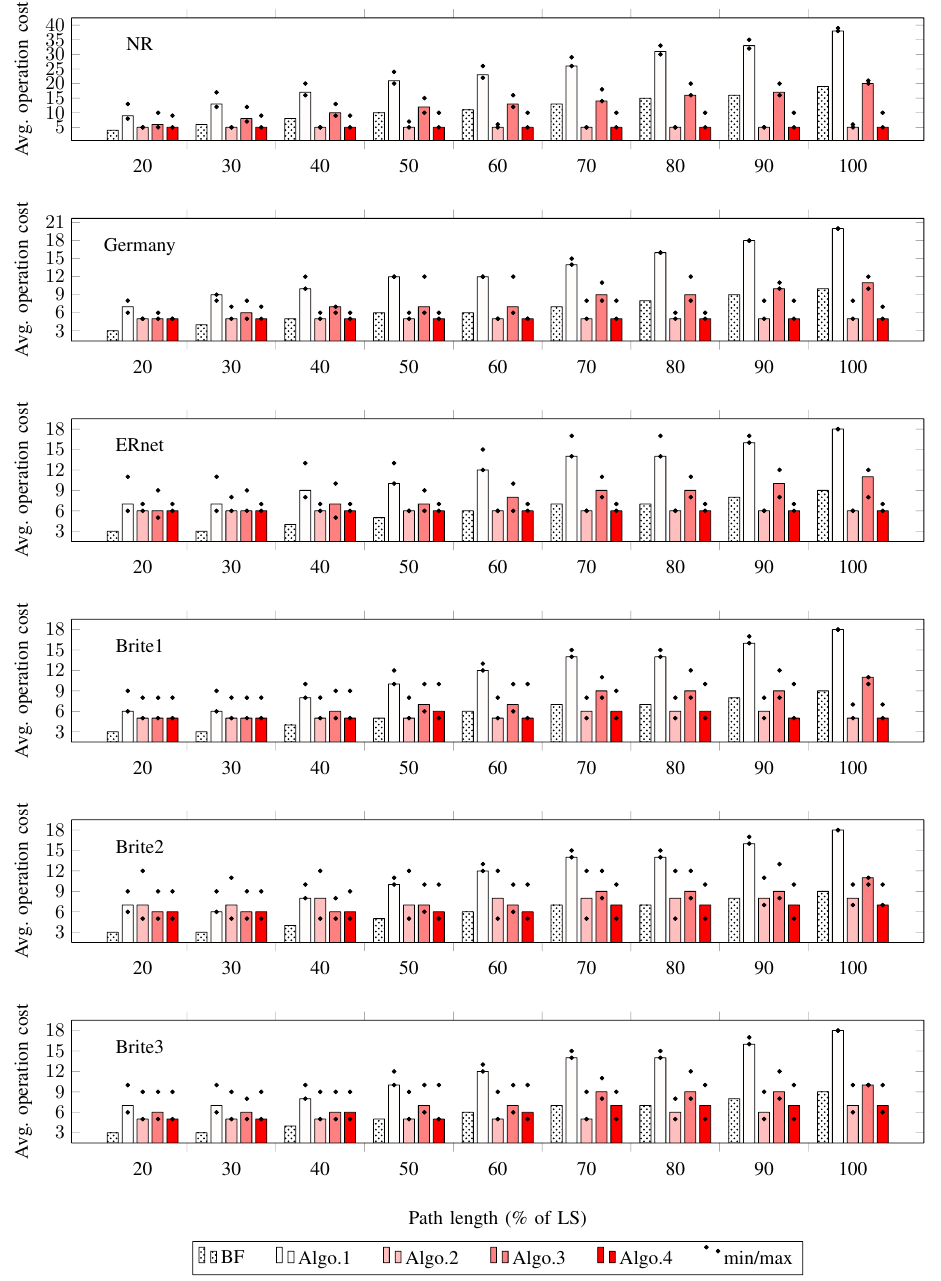
Fig. 8. The average path operation cost, i.e. number of add and remove forwarding rules, achieved by Algorithms 1, 2, 3 and 4 for the experimental topologies Figure 8. The average path operation cost, that is, number of add & remove entries, achieved by of Table I Algorithms 1–4 for the experimental topologies of Table